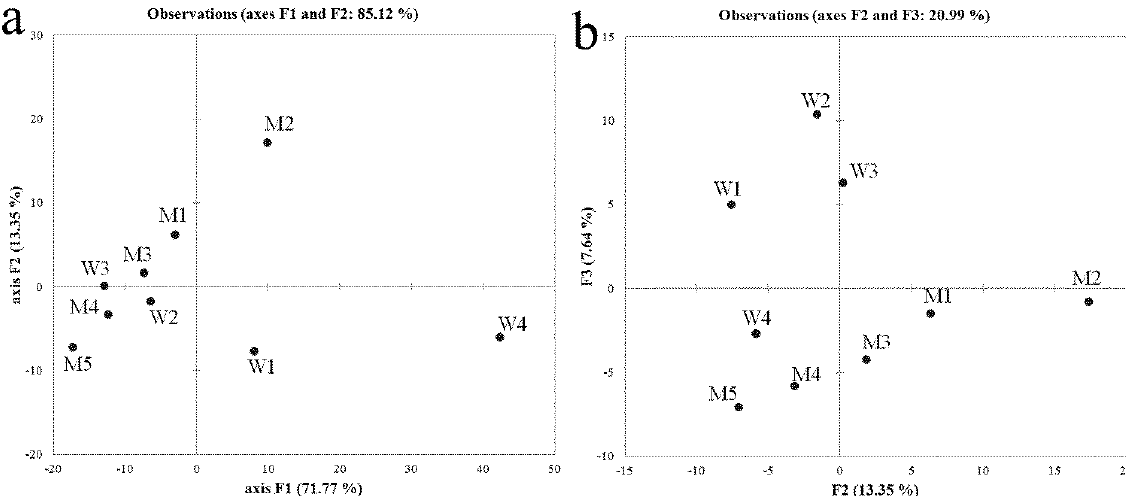
Figure 2. Principal component analysis (PCA-analysis) results for bacterial denaturing gradient gel electrophoresis (DGGE) band patterns. ( a ) First principal component (F1) vs. second principal component (F2); ( b ) F2 vs. third principal component (F3); ( c ) F3 vs. fourth principal component (F4). W, sludge samples; M, fouled filtration